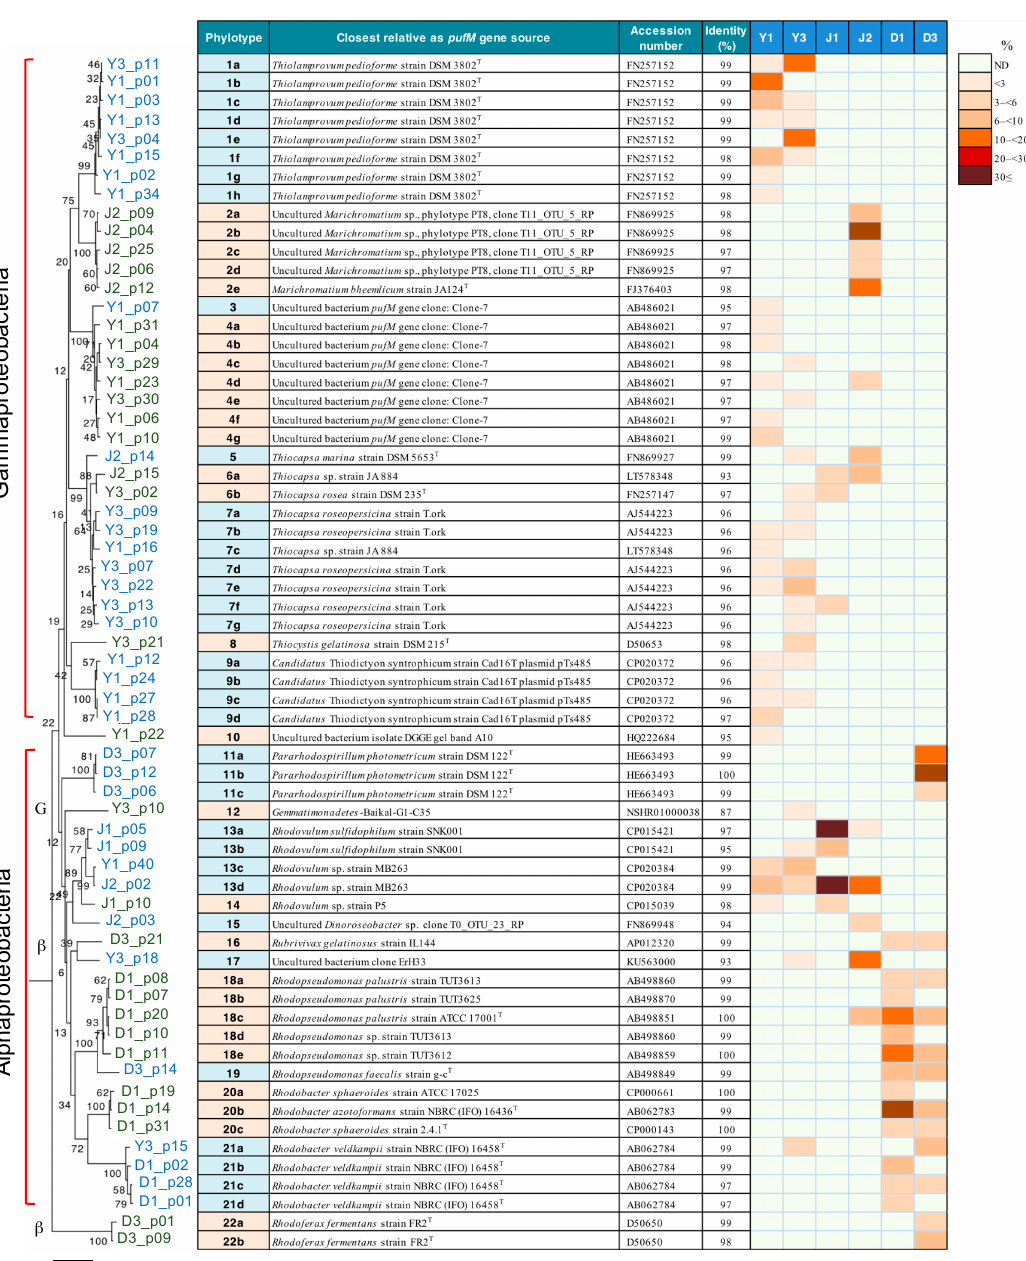
Figure 5. Neighbor-joining phylogenetic tree of the 64 unique pufM gene clones, divided into 22 major phylotypes, the assignment to their closest relatives, and a heat map showing their percentage distribution in six selected blooms / mat samples, Y1, Y3, J1, J2, D1, and D3. Chloroflexus aggregans DSM 9485 T (accession number, CP001337) was used as an outgroup to root the tree. The percentages of bootstrap confidence values by 1000 replications are given at the nodes of the tree. The letters G and β with shaded parts in the phylogenetic tree shows the lineages of Gemmatimonadetes and Betaproteobacteria , respectively. Scale bar = 0.1 substitution per position.